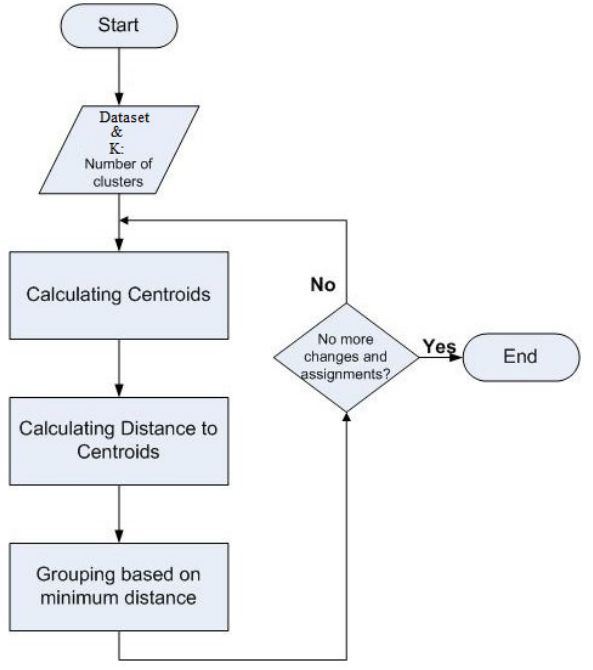
Figure 1. K-means Clustering Algorithm